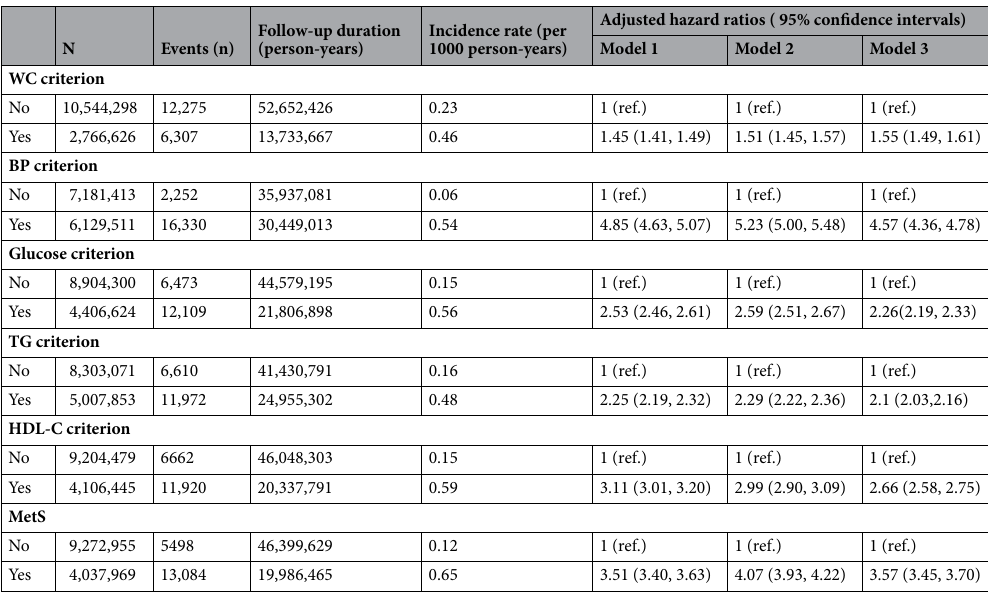
Table 2. Adjusted hazard ratios, 95% confidence intervals, and incidence rates of end-stage renal disease development according to the presence of each MetS component. Model 1, adjusted for No. of MetS components at 1st visit, age and sex; Model 2, Model 1 plus adjusted for smoking, drinking and exercise; Model 3, Model 2 plus adjusted for estimated GFR. WC waist circumference, BP blood pressure, TG triglyceride, HDL-C high-density lipoprotein cholesterol; MetS, metabolic